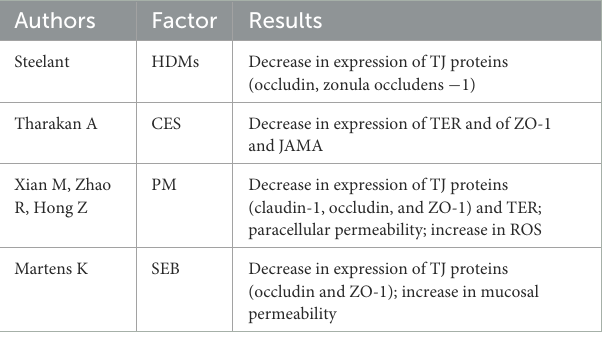
TABLE 2 Studies describing the various factors affecting epithelial barrier